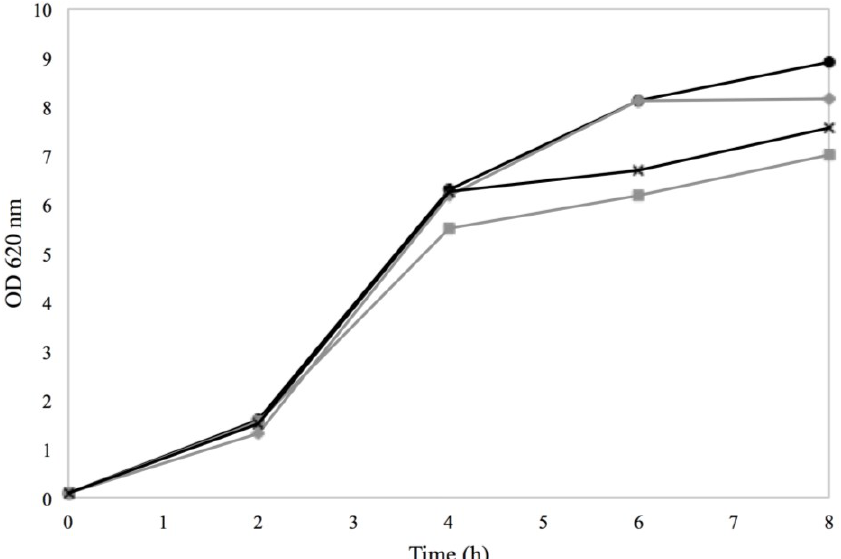
Figure 6. Growth in batch cultivation of Sa17 cells under exposure to either NaCl stress or optimal conditions. The cells were pre-grown under optimal or NaCl stress. The Y axis represents OD measured at 620 nm and the X axis the time in hours. The different treatments investigated are designated with different symbols. Co–Co is presented with (●), Co–Na with (■), Na–Co with (♦) and Na–Na with ( × ). The results are obtained from one